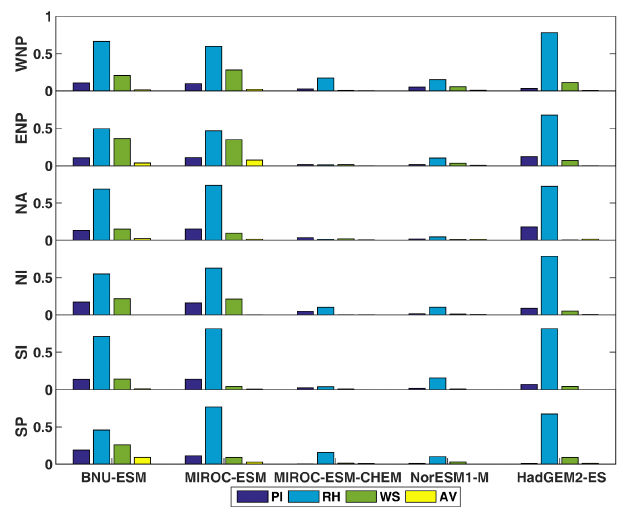
Figure 5. The fractional variance contribution of components of GPI during the TC season and within the six TC basins during